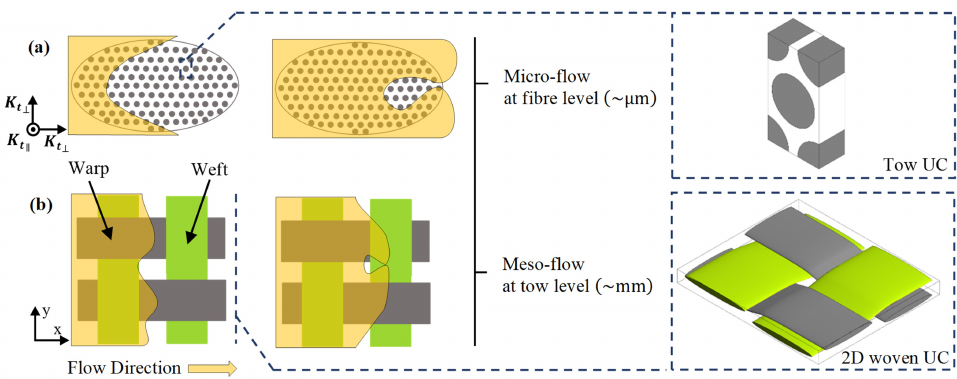
Figure 1. Void formation ( a ) inside the intra-tow region (microscopic level), ( b ) between the yarns (mesoscopic